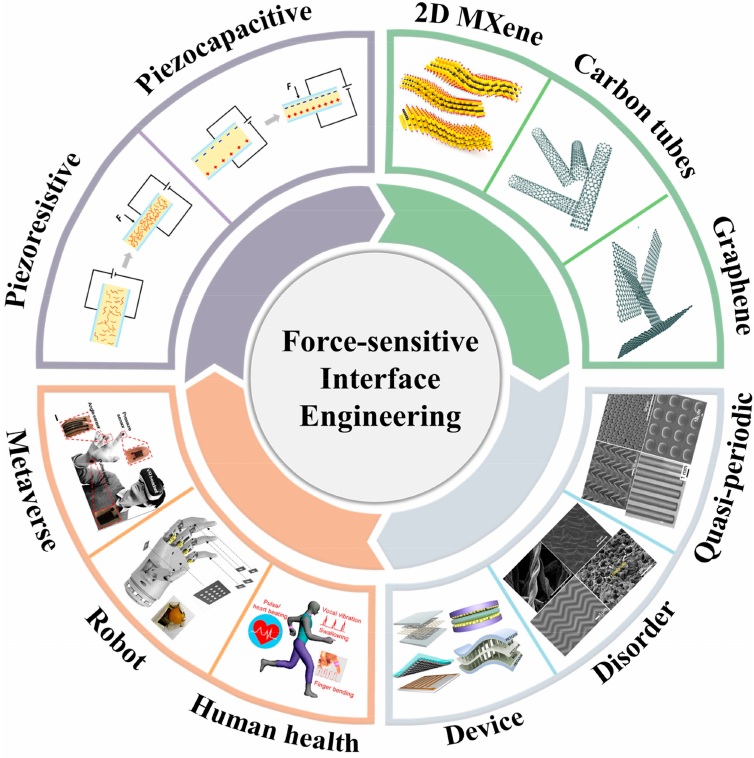
Figure 1. A diagram about principle, material, device structure, and application of the flexible pressure sensor obtained through the adjustment of the force-sensitive interface. Images